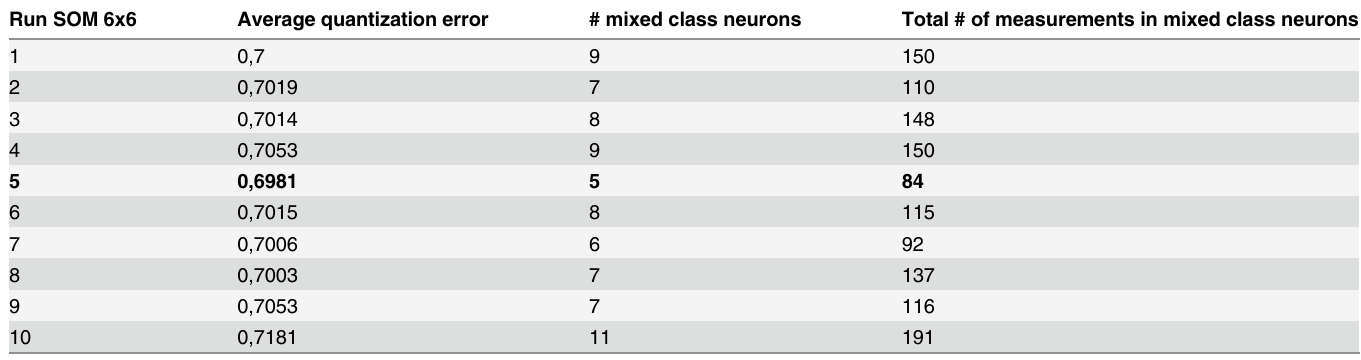
Table 5. Features of different SOM runs for the four classes of trisomic mice.